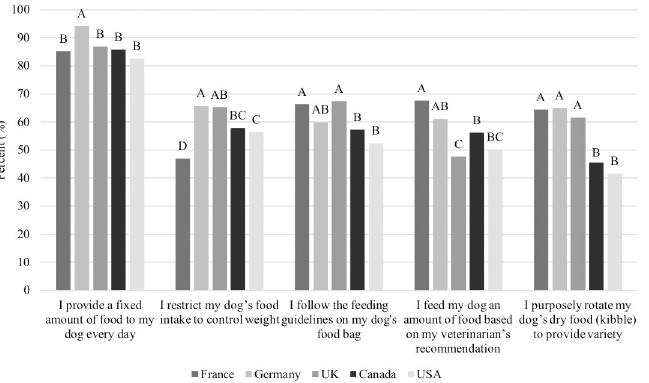
Fig 4. Percent of respondents that answered ‘true’ to the five feeding statements, among countries (n = 3,298). Proportions in the same category that do not share a common letter are significantly different at P < 0.05.